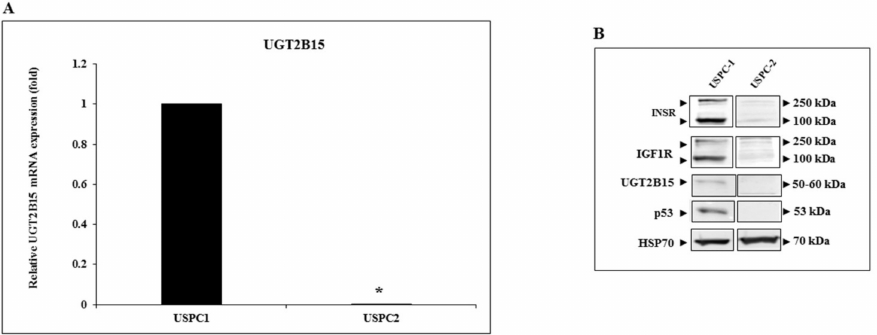
Figure 2. Expression of UGT2B15 in endometrial cancer cell lines. ( A ) Total RNA was obtained from confluent USPC-1 and USPC-2 endometrial cancer cell lines and UGT2B15 mRNA levels were measured by RT-QPCR. A value of 1 was assigned to the UGT2B15 mRNA levels in USPC-1 cells. * p < 0.01 vs. USPC-1 cells. ( B ) Total protein was obtained from confluent USPC-1 and USPC-2 cell lines and UGT2B15, IGF1R, INSR, and p53 protein levels were measured by Western blots. HSP70 levels were assessed as a loading control.